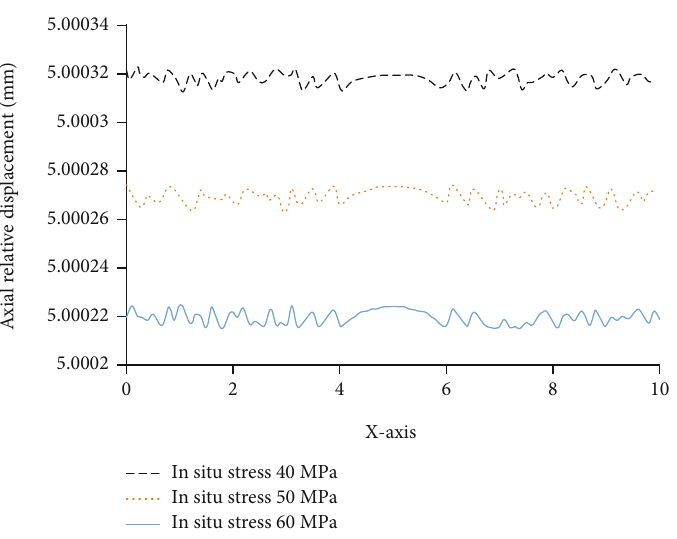
Figure 25: Relative axial displacement diagram of two rock slabs under di ff erent crustal stresses (elastic modulus 40GPa).